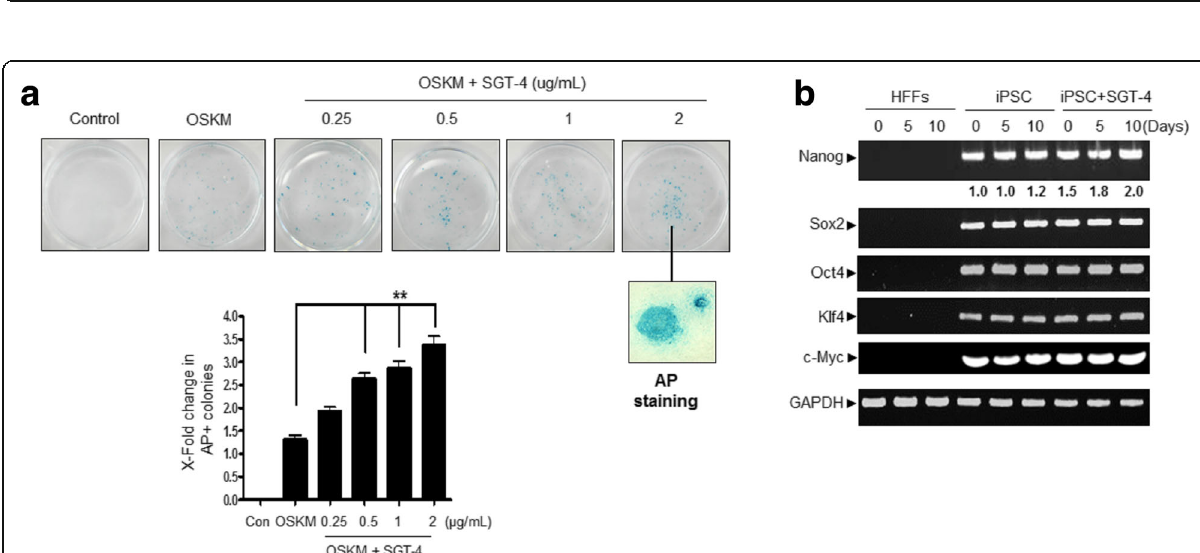
Fig. 3 SGT-4 promotes hiPSC generation. a and b Estimated timeline of hiPSC generation and the relative number of generated AP + colonies. After the cells were transfected with OSKM, they were maintained in HFF medium for 5 days, after, which they were treated with one of multiple doses of SGT-4 and transferred into human embryonic stem cells medium. The images highlight the comparison of the number of AP + colonies generated from HFFs. c Immunostaining of the pluripotent-associated markers (Oct4, Nanog, and Sox-2) and counterstaining with β -actin antibodies